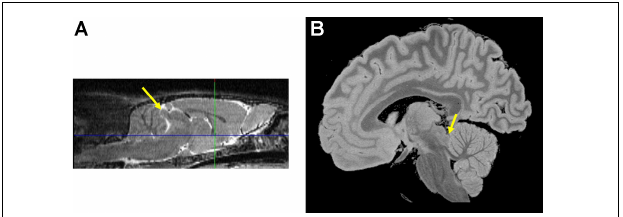
FIGURE 1 | The inferior colliculus (yellow arrows) on sagittal images from a (A) wild type Wistar rat and a (B) postmortem formalin fixed human brain specimen. Images compliments of Adolf Pfefferbaum, M.D., SRI